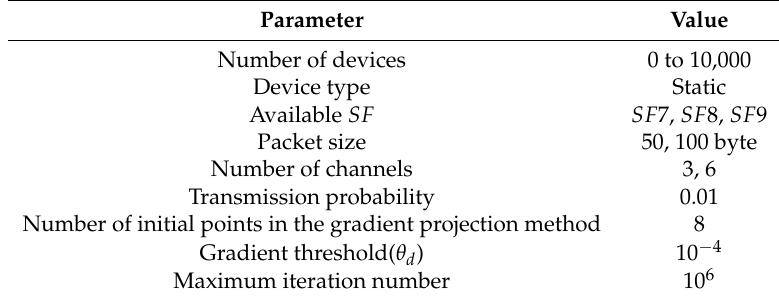
Table 3. Parameter